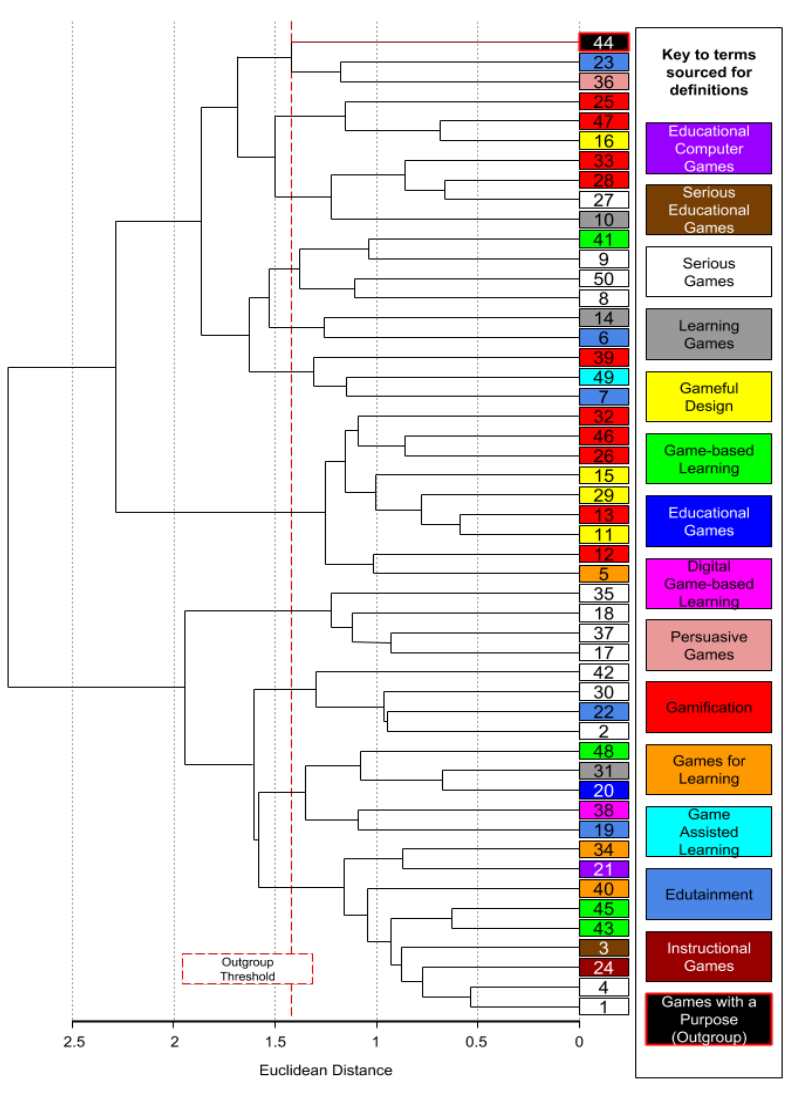
Figure 2. Dendrogram of item definition interrelationships. Branch length is Euclidean distance, color of items corresponds to associated terms in